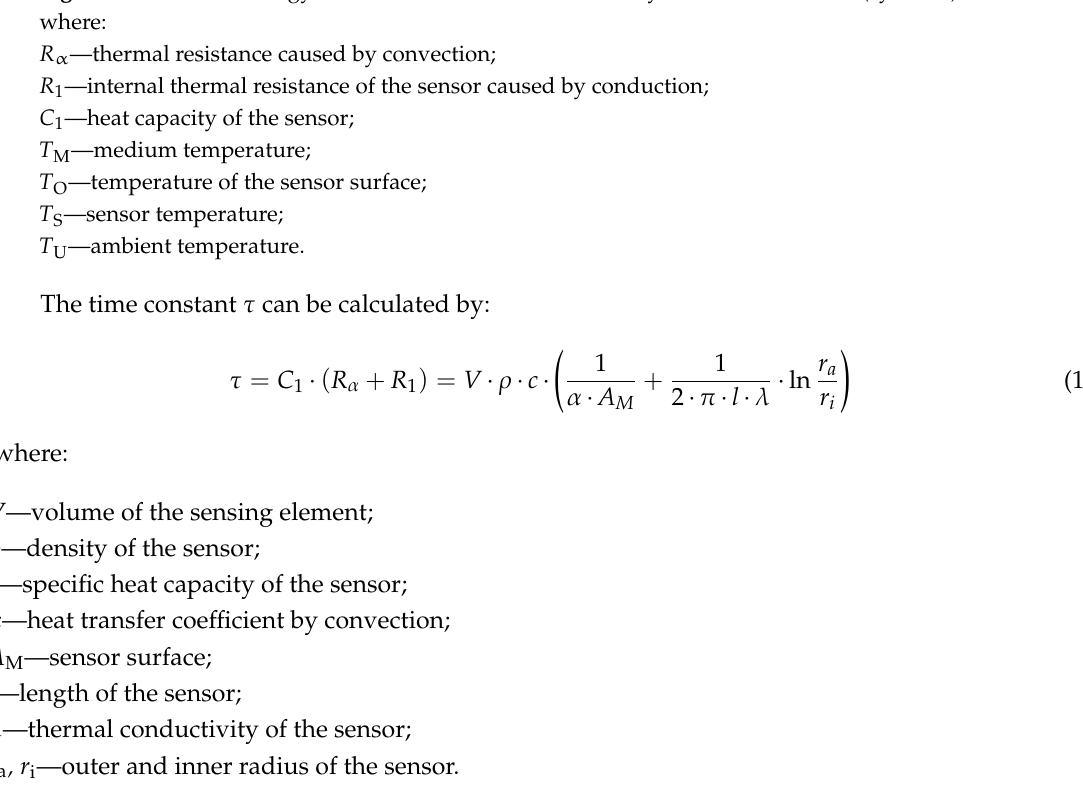
Figure 1. Electrical analogy model of the first-order time delay element of a sensor (cylinder).